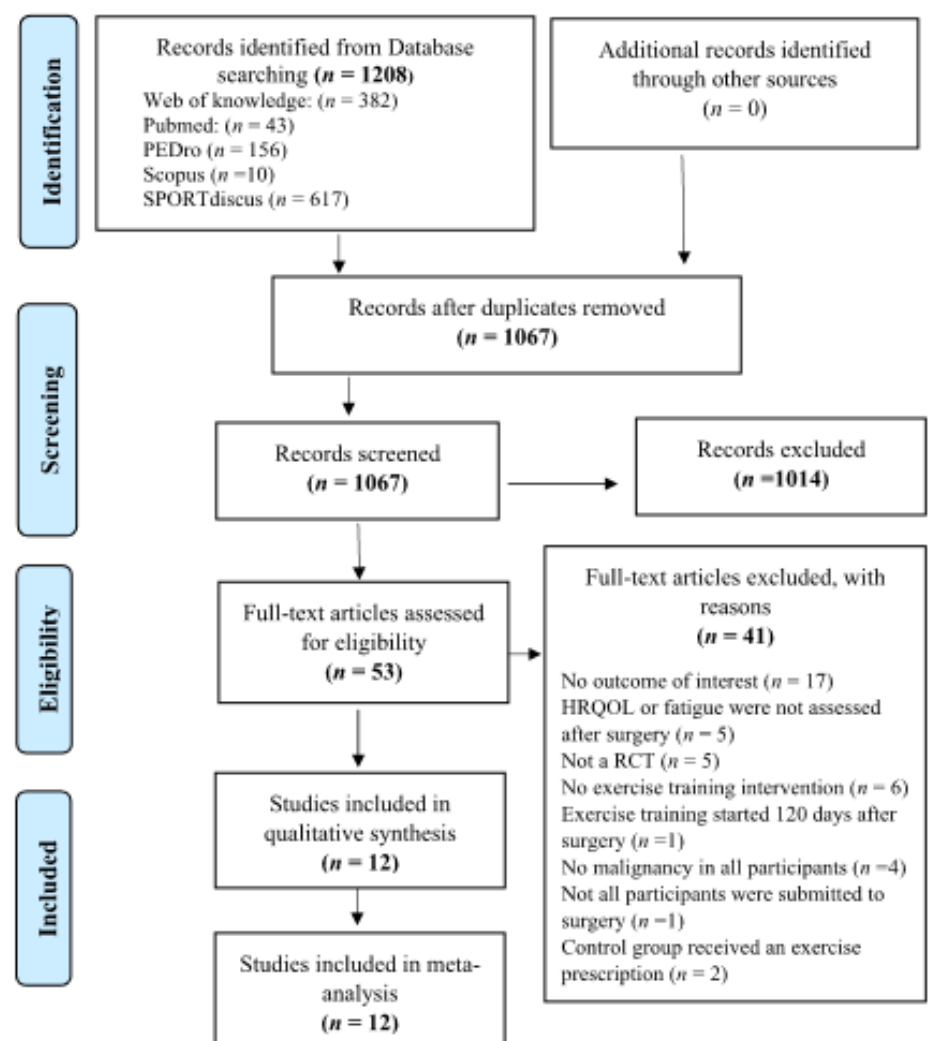
Figure 1. PRISMA flowchart of process of identification of eligible studies; HRQOL (Health-related quality of life); RCT (randomized controlled trial).